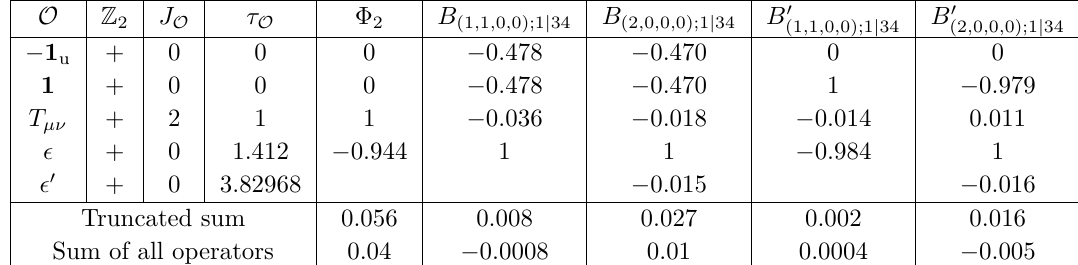
. The values are normalized with respect to σσ O sum rule. All other 2